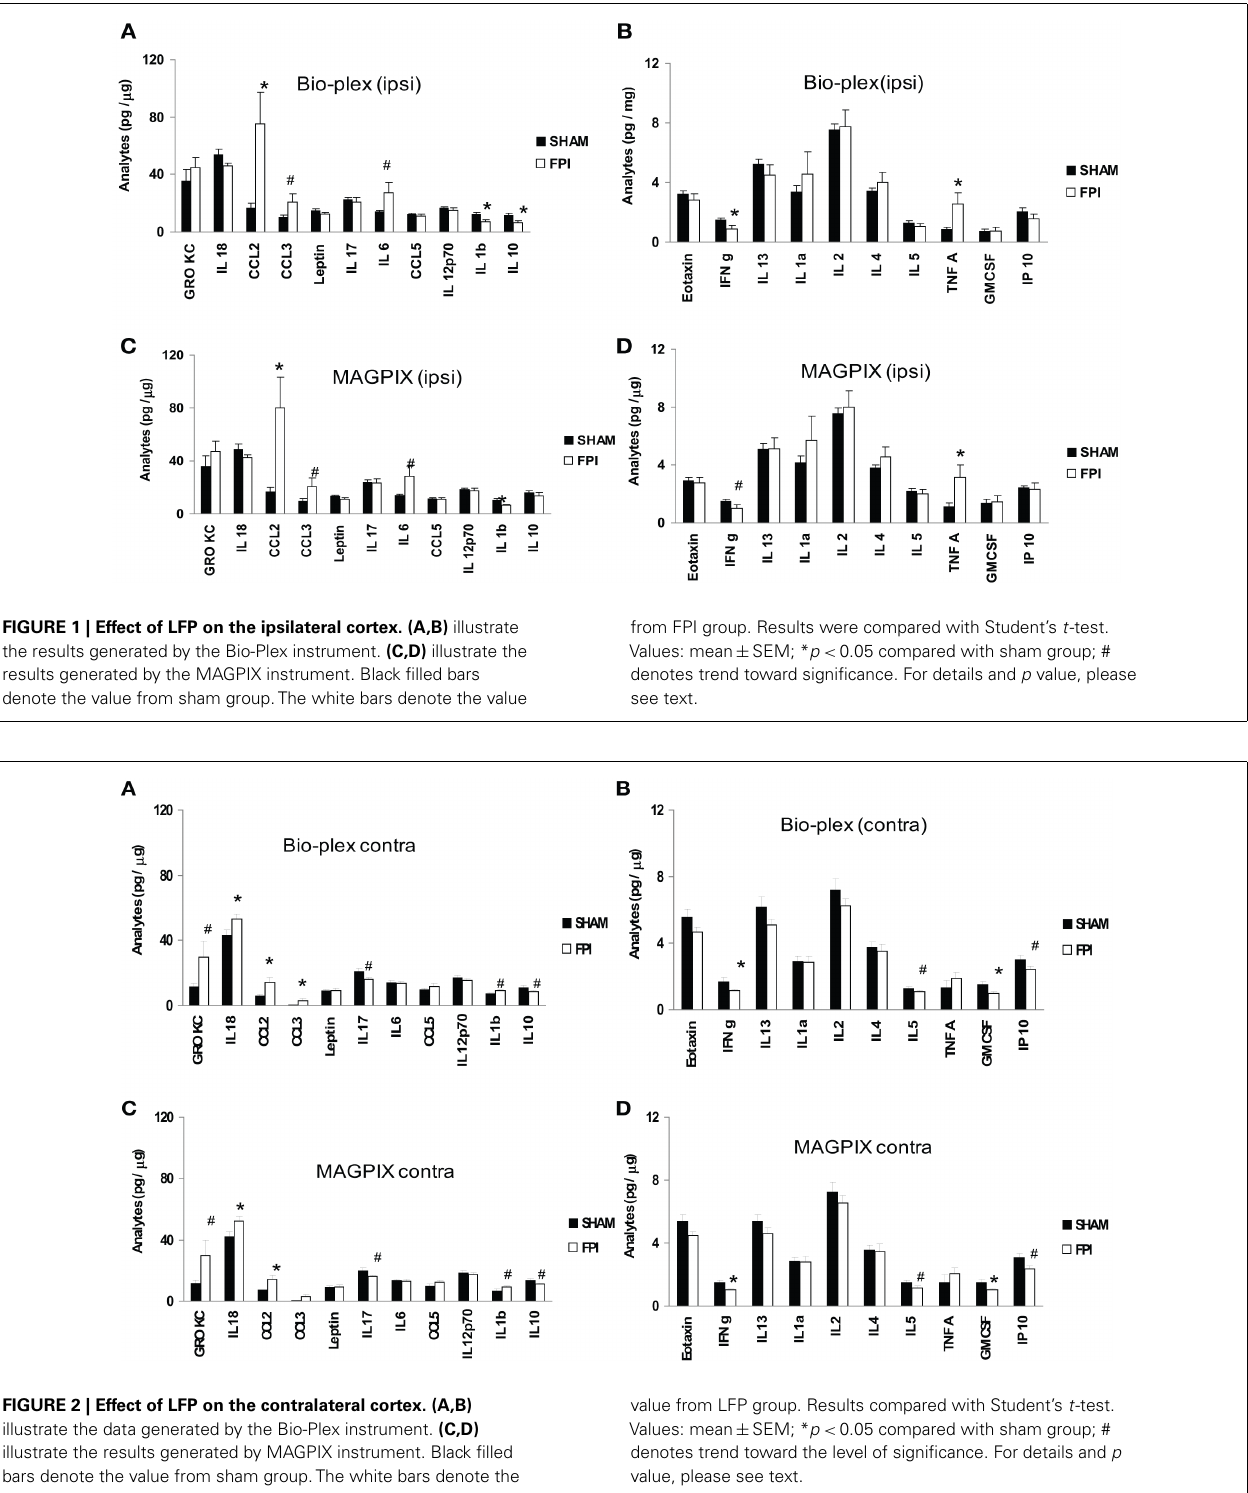
value from LFP group. Results compared with Student’s t -test. Values: mean ± SEM; * p < 0.05 compared with sham group; # denotes trend toward the level of significance. For details and p value, please see